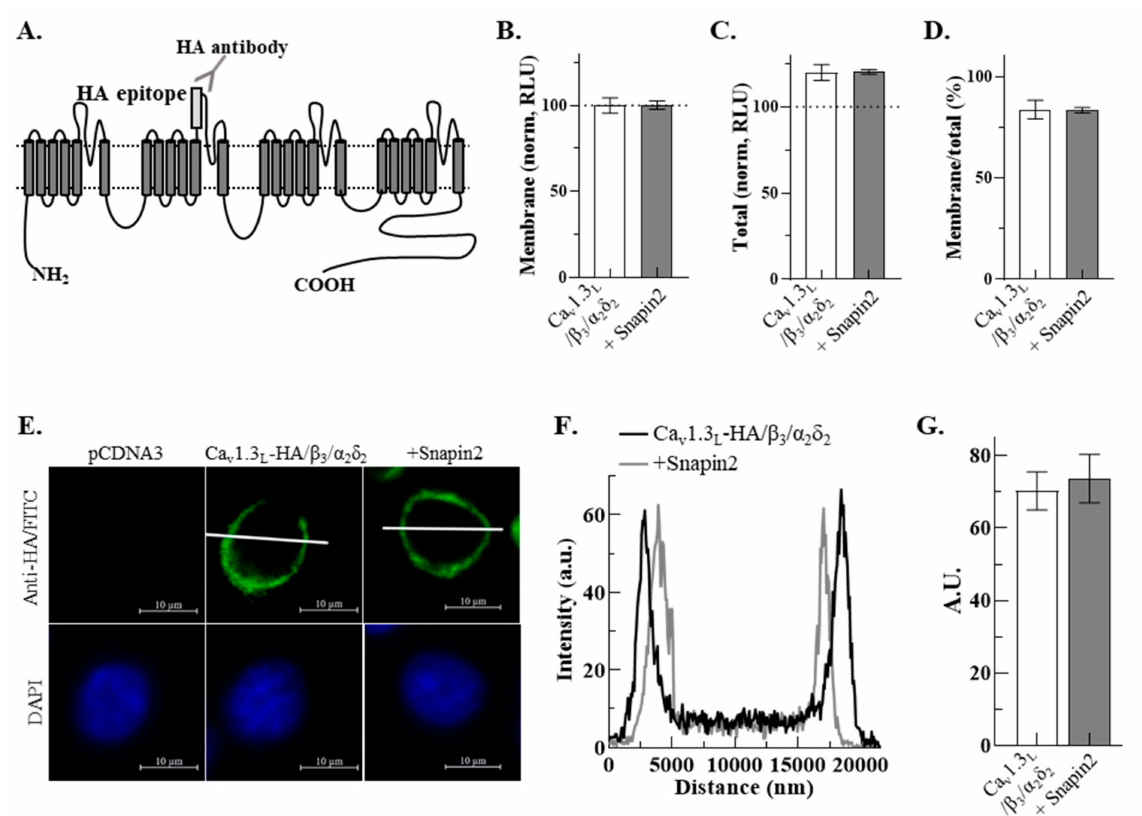
Figure 7. The surface and total expression of Ca v 1.3 L channels was not changed by Snapin2. ( A ) Schematic diagram of Ca v 1.3 L -HA. The HA epitope was tagged at the extracellular S5-pore loop of Ca v 1.3 L domain II (refer to the method section). ( B – D ) Luminometric quantification of expression levels of Ca v 1.3 L -HA without or with Snapin2. ( B ) Surface expression measured in non-permeabilized HEK-293 cells expressing Ca v 1.3 L -HA/ β 3 / α 2 δ 2 without or with Snapin2. The luminescence intensities (arbitrary unit) were 3.75 × 10 7 ± 0.25 × 10 7 and 3.86 × 10 7 ± 0.20 × 10 7 (n = 8). Their normalized values (relative luminescence unit, RLU) are represented as bar graphs. ( C ) Total expression measured in permeabilized HEK-293 cells expressing Ca v 1.3 L -HA/ β 3 / α 2 δ 2 without or with Snapin2. The luminescence values of total expression are 3.95 × 10 7 ± 0.05 × 10 7 and 4.35 × 10 7 ± 0.20 × 10 7 (n = 8). RLU values were obtained by normalizing luminescence values to the non-permeabilized Ca v 1.3 L -HA/ β 3 / α 2 δ 2 signal. ( D ) Ratios of surface/total expression are represented as bar graphs. The ratios are not significantly different between with or without Snapin2. ( E ) Confocal microscopy images of surface expression of Ca v 1.3 L -HA without or with Snapin2. A set of HEK-293 cells transfected with Ca v 1.3 L -HA/ β 3 / α 2 δ 2 without or with Snapin2 was stained with anti-HA antibodies and then FITC conjugated secondary antibodies. The middle and right panels show representative fluorescence images for Ca v 1.3 L -HA with or without Snapin2 (n = 3). The negative control image was from cells transfected with pCDNA3 vector (left panel). DAPI stained images of corresponding cells are shown in the lower panels. ( F ) Line-scanning analyses of Ca v 1.3 L -HA expression. Representative line-scan profiles of cells expressing Ca v 1.3 L -HA without (black line) or with Snapin2 (gray line) were obtained by a software program provided by ZEISS. ( G ) The maximal intensity values (arbitrary unit, a.u.) across the cells are represented as bar graphs, showing no statistically significant difference (70.3 ± 5.3 and 73.7 ± 6.6 a.u.; n =